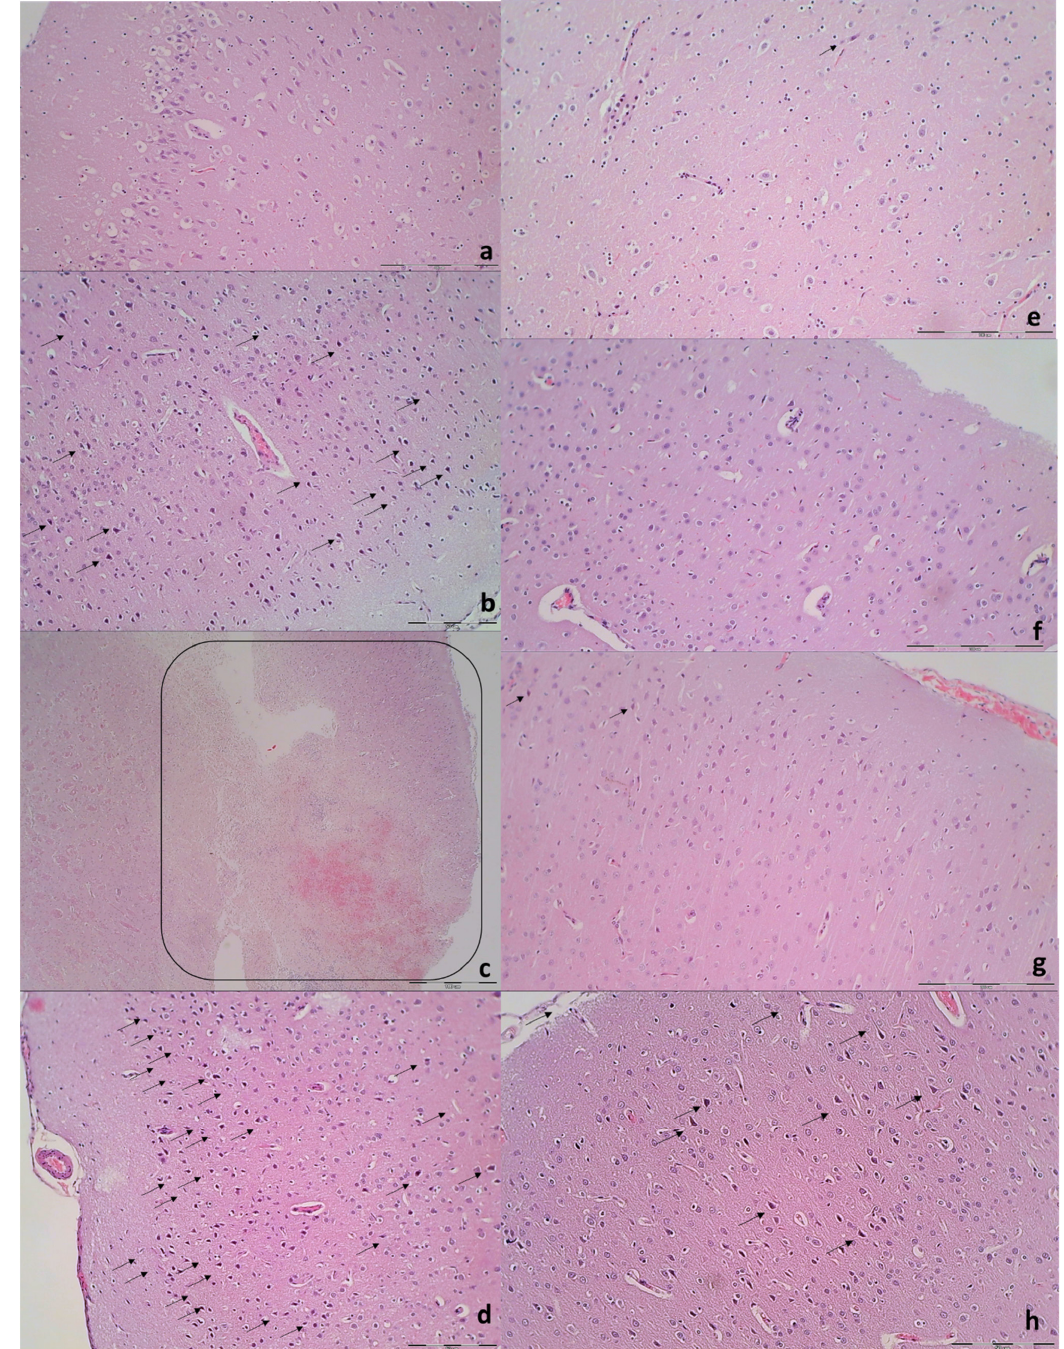
Figure 11. Neuropathologic changes in cerebral cortex areas (HE staining). Increased edema and congestion in control group ( a – d ) unlike BPC 157 rats ( e – h ). Application at ligation-time 15 min. ( a ) Control (1 min upon saline administration), a scant karyopyknosis in cerebral cortex, ligation-time 16 min; ( b ) Control (5 min upon saline administration), larger number of karyopyknotic neurons (arrows), ligation-time 20 min; ( c ) Control 24 h ligation-time (saline administration at 1 min ligation-time), complete infarction (rectangular marked area); ( d ) Control 48 h, ligation-time (saline administration at 1 min ligation-time, marked karyopyknosis (arrows)). BPC 157 rats exhibit a few karyopyknotic neurons (arrows) ( e – h ). ( e , f ) BPC 157 application at 15 min ligation-time, intragastric BPC 157 therapy, 1 min after application ( e ), or 5 min after application ( f ). ( g , h ) BPC 157 intragastric administration at 1 min ligation-time: 24 h ligation-time ( g ), 48 h ligation-time ( h ). Magnification × 200 (( a , c , e – g ); scale bar 100 µ m), × 200 (( b , d , h ); scale bar 50 µ